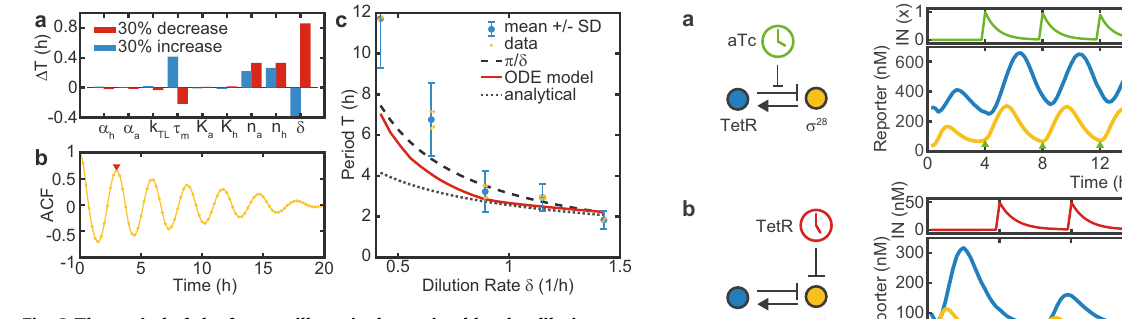
Fig. 2, with α = 3 pMs − 1 .